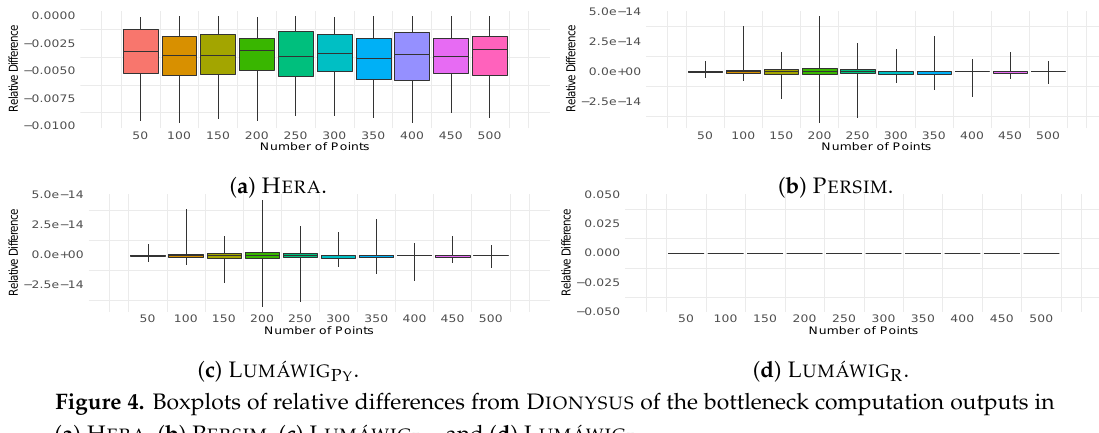
Figure 4. Boxplots of relative differences from D IONYSUS of the bottleneck computation outputs in ( a ) H ERA , ( b ) P ERSIM , ( c ) L UMÁWIG P , and ( d ) L UMÁWIG R . Y